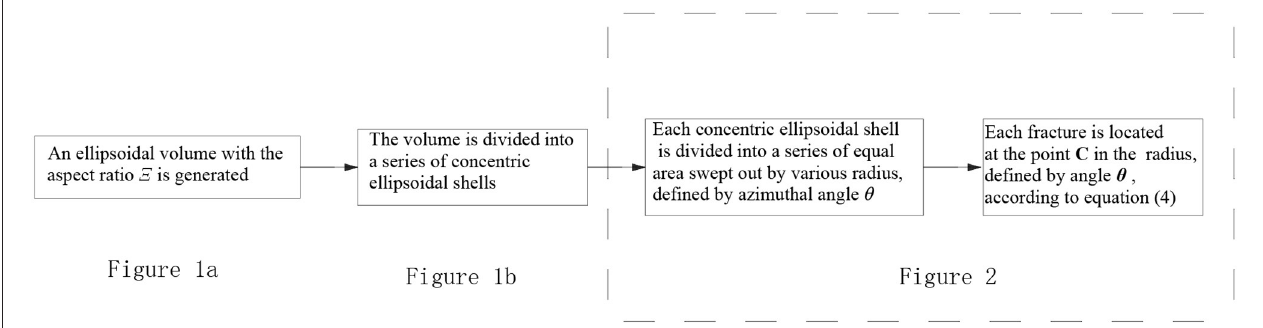
FIGURE 3 | A work flow chart to describe the generation procedure for the fracture set in the damage zone.